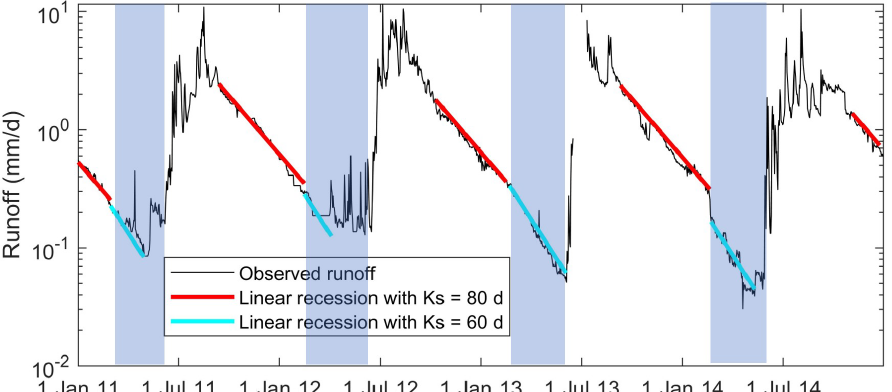
Figure 5. Groundwater recession, from 2011 to 2014, on a logarithmic scale, with linear recession parameter K s = 80d in the early recession periods and K s = 60d at the end of the recession